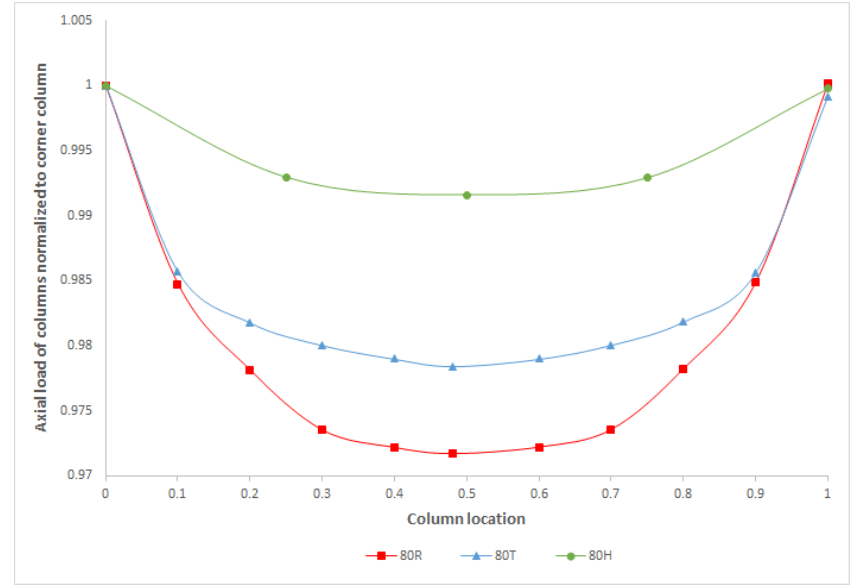
Figure 6. Shear lag diagram of 60th story of 80 story models subjected to the dynamic earthquake load.